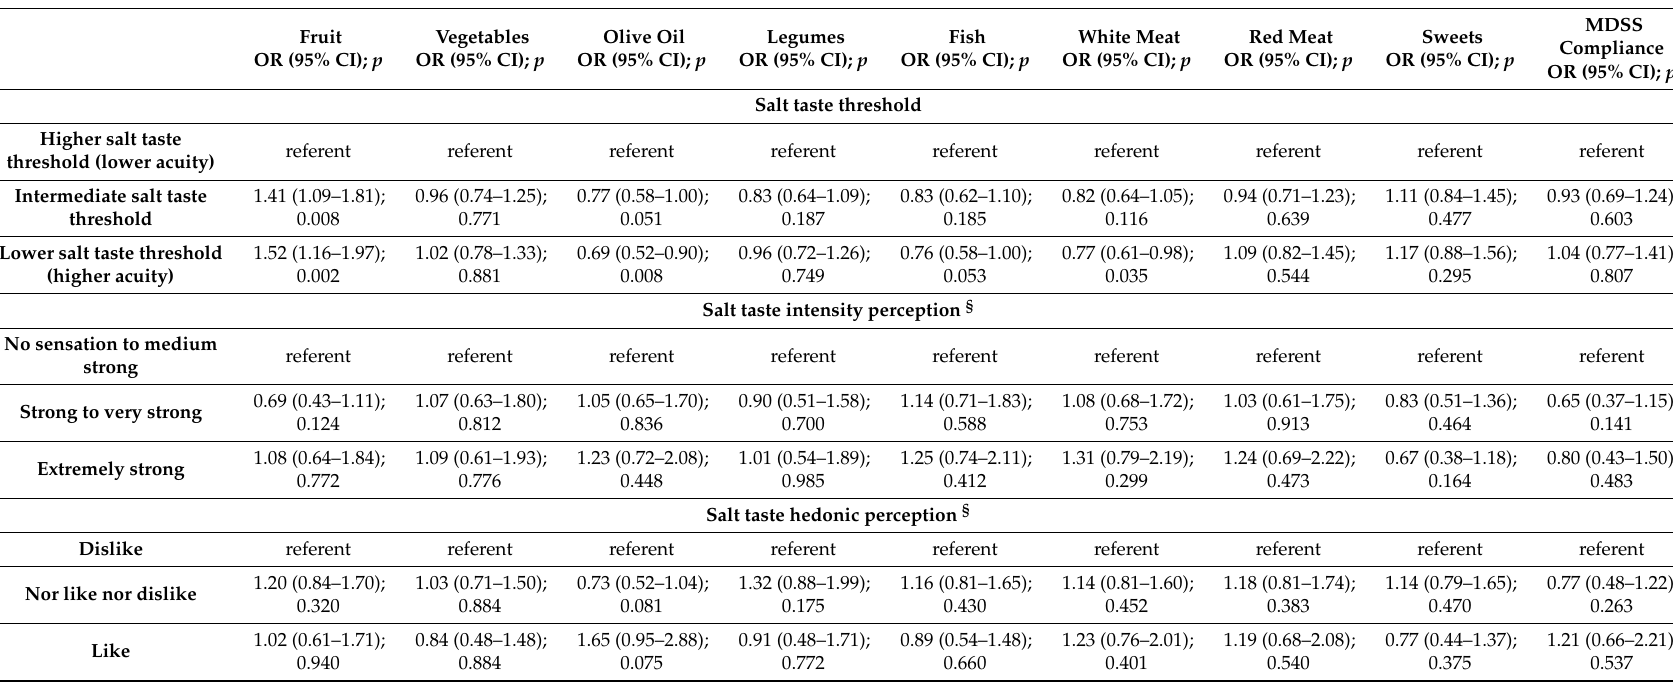
Table 4. Association between Mediterranean diet compliance and salt taste threshold and suprathreshold perception. Fruit OR (95% CI);